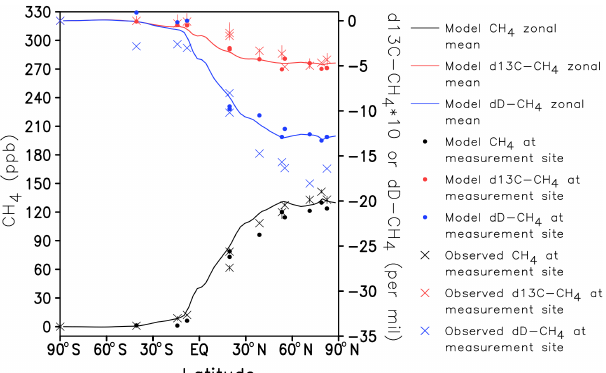
Figure 4. The difference between surface annual mean CH 4 , δ 13 C- CH 4 and δ D-CH 4 and South Pole annual mean values for CH 4 , δ 13 C-CH 4 and δ D-CH 4 . Results from the p-TOMCAT BASE sce- nario (including sampling the model at station locations) are com- pared to NOAA-ESRL and CU-INSTAAR observations. Where there are sufficient data available in the 2005–2009 period, the range in annual mean station South Pole observed differences is repre- sented by a vertical bar. CH 4 mixing ratios are shown in black, δ 13 C-CH 4 in red and δ D-CH 4 in blue. Variations in δ 13 C-CH 4 have been multiplied by a factor of